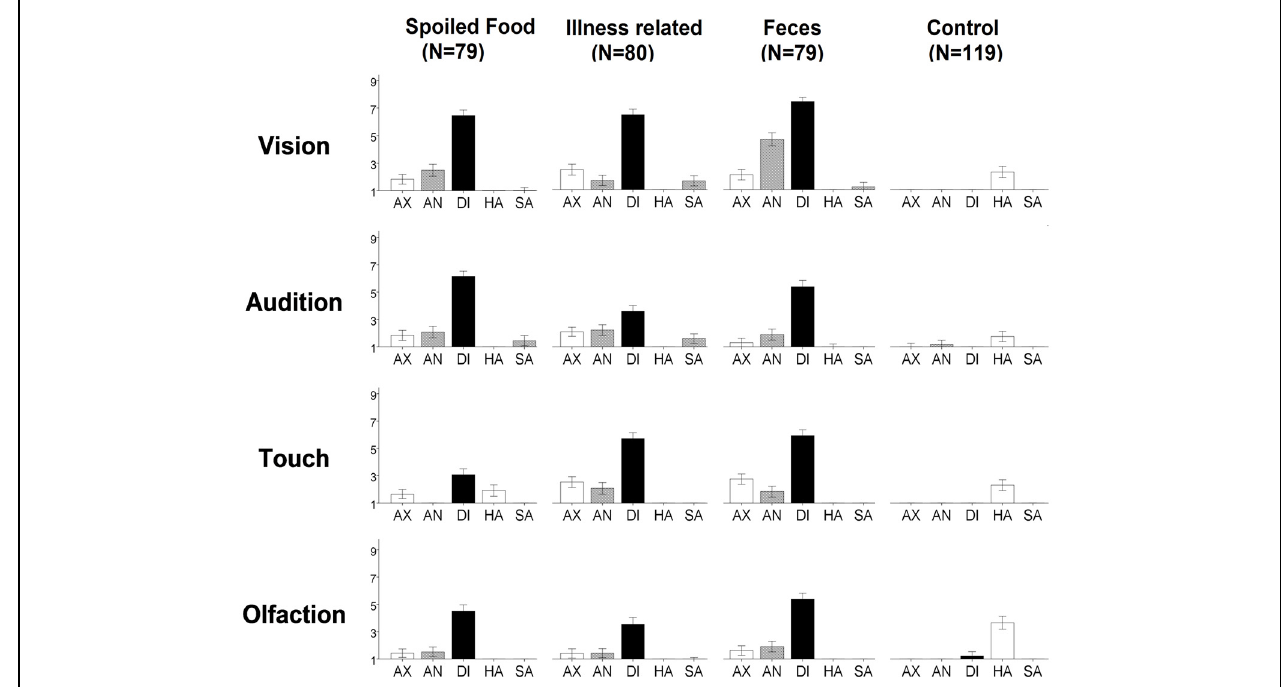
FIGURE 2 | Ratings of evoked emotion for each stimulus. The y-axis represents the rating between 1 “not at all” and 9 “extremely strong” for the emotions anxiety (AX), anger (AN), disgust (DI), happiness (HA), and sadness (SA). Note: Error bars indicate 95% confidence interval.